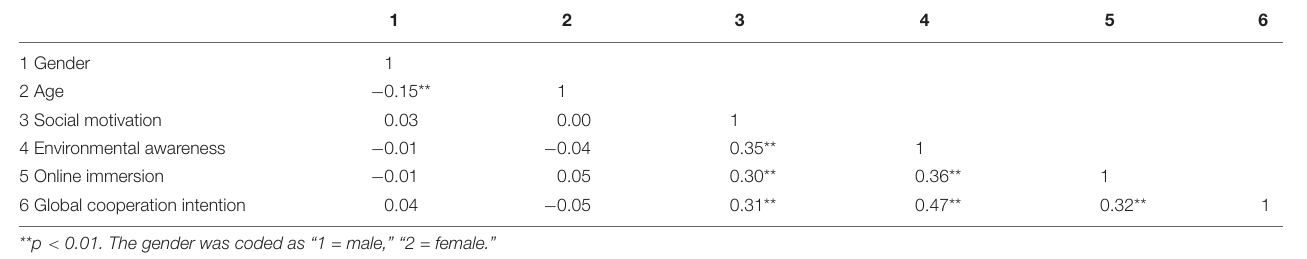
TABLE 2 | Spearman’s correlations between main variables.